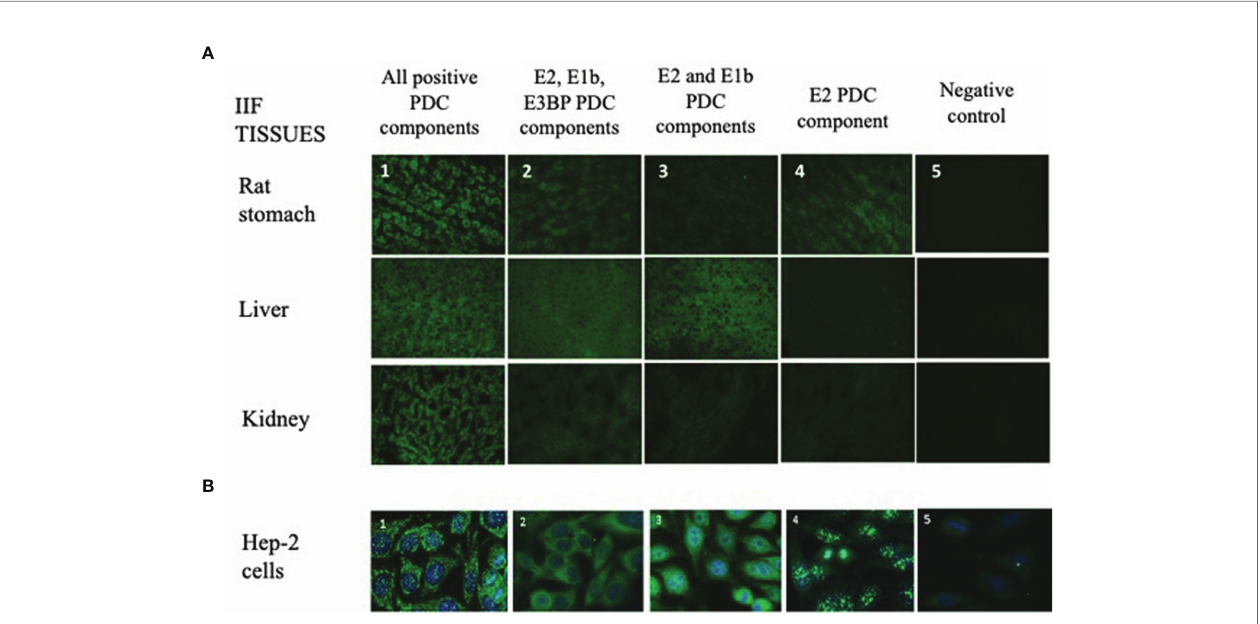
FIGURE 1 | Different IIF patterns of AMA-positive patients on tissue sections and HEp-2 cell slides. (A) The IIF analysis on tissues ( fi rst row: rat stomach; second row: liver; third row: kidney) is used in routine laboratories as a screening technique of AMA-positive samples, and it shows different IIF intensities concordant with the different expressions of the PDC autoantigens (1, 2, 3, 4, 5; ×40 objective). 1: IIF pattern of a patient positive for all PDC autoantibodies (E1a, E1b, E2, E3, E3bp). 2: IIF pattern of a patient with autoantibodies to only E2, E1b, and E3BP components. 3: IIF pattern of a patient with autoantibodies to only E2 and E1b components. 4: IIF of a patient positive only for the E2 component. 5: Negative control. (B) Different IIF patterns of AMA-positive sera on HEp-2 cell slides. This method shows different cytoplasmic staining patterns with variable recognition of the PDC antigens (1, 2, 3, 4, 5) using the ×40 objective. These 5 panels correspond to the same 5 panels and patients ’ samples shown in panel (A) . AMA, antimitochondrial antibodies; IIF, indirect immuno fl uorescence; PDC, pyruvate dehydrogenase